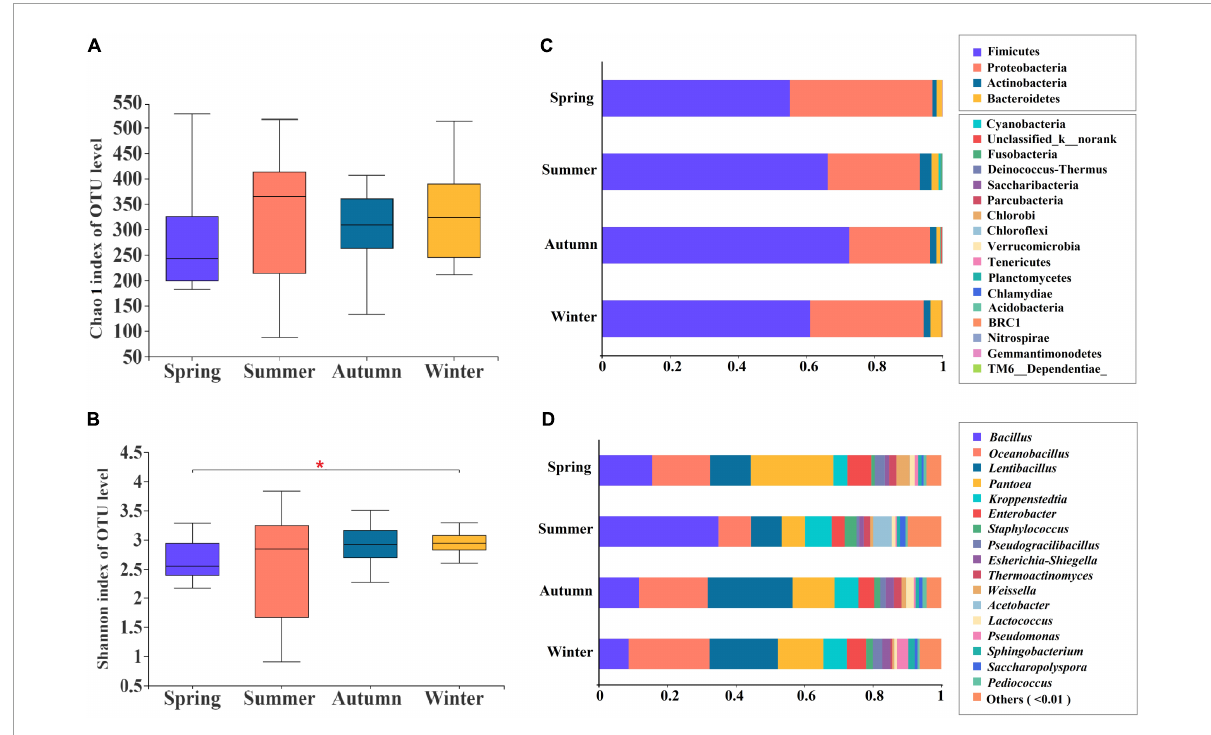
FIGURE2 Chao 1 (A) and Shannon (B) indices of bacterial α -diversity, and the bacterial community structure at the level of phylum (C) and genus (D) in different seasons. * P <